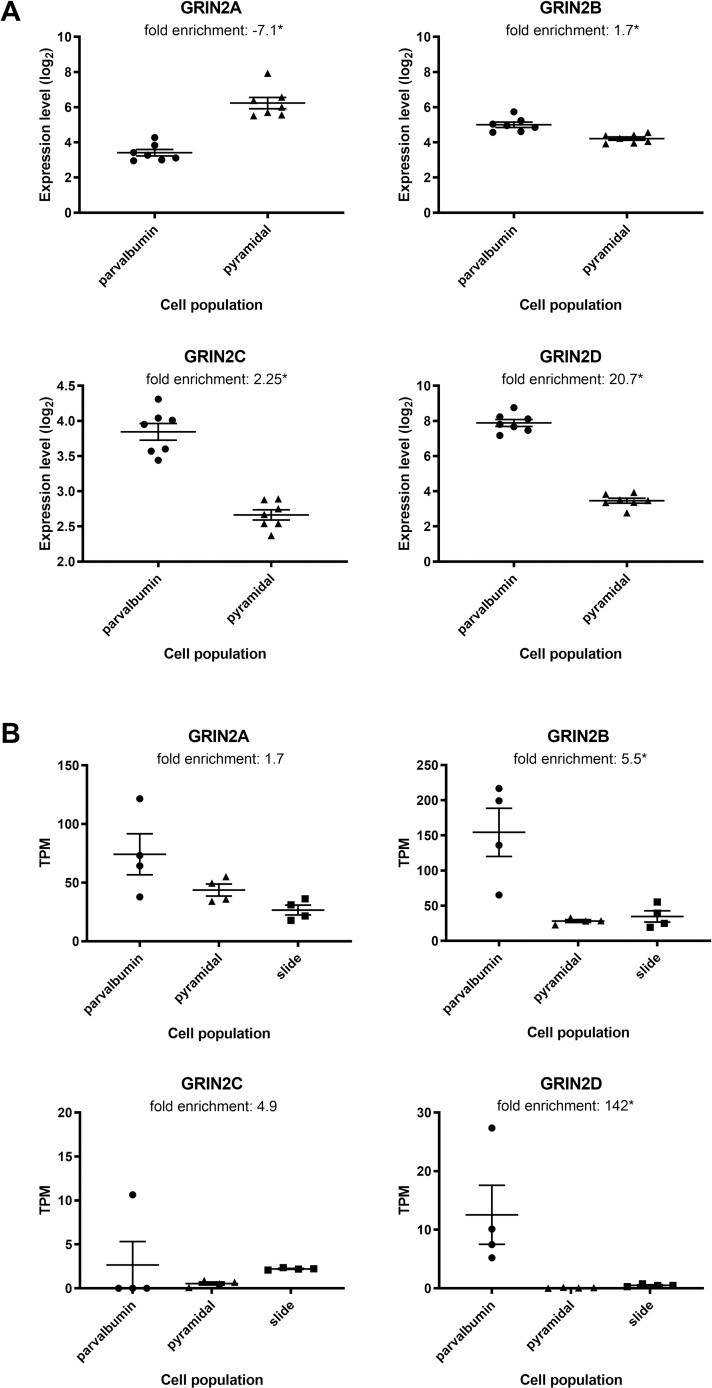
GluN2D transcripts are enriched in PV interneurons relative to pyramidal neurons in the dlPFC.(A) Gene expression data as measured by microarray is plotted for GluN2A, B, C and D, and enrichment in one cell type versus the other is listed. Triangles represent pyramidal neurons, circles represent parvalbumin interneurons; intensity is expressed on a log2 scale. *p<0.05 for parvalbumin versus pyramidal neurons. (B) Gene expression data measured from a separate cohort of samples by RNAseq is presented for pyramidal neurons (triangles), parvalbumin interneurons (circles), and adjacent sections on LCM slides (squares). Fold enrichment between parvalbumin neurons and pyramidal neurons is listed above each graph. The y-axis represents the absolute value of gene expression as TPM. *p<0.05 for parvalbumin versus pyramidal neurons.